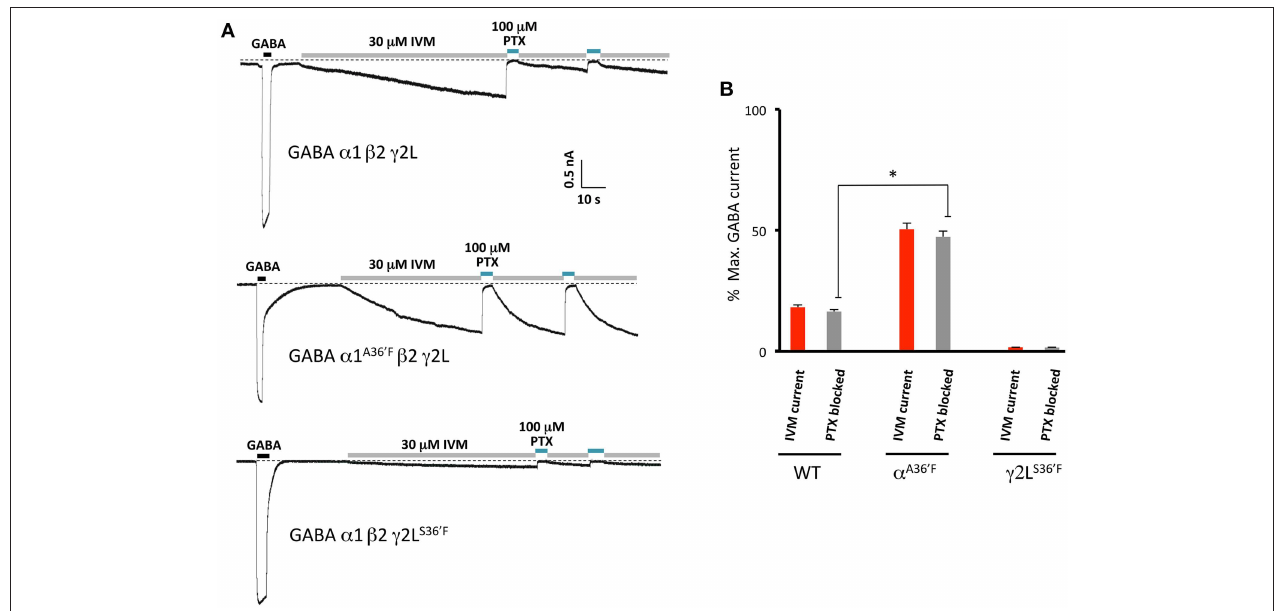
FIGURE 9 | Picrotoxin block of currents directly activated by ivermectin. (A) Examples of ivermectin activation and picrotoxin block of GABA A Rs comprising the indicated subunits. (B) Averaged picrotoxin block data from (A) compared with averaged ivermectin irreversible activation data from Figure 5E . All results were averaged from at least 4 cells. This confirms that direct ivermectin activation requires receptors with intact γ 2L- β 2 interfaces. * Represents significance of t -test P <